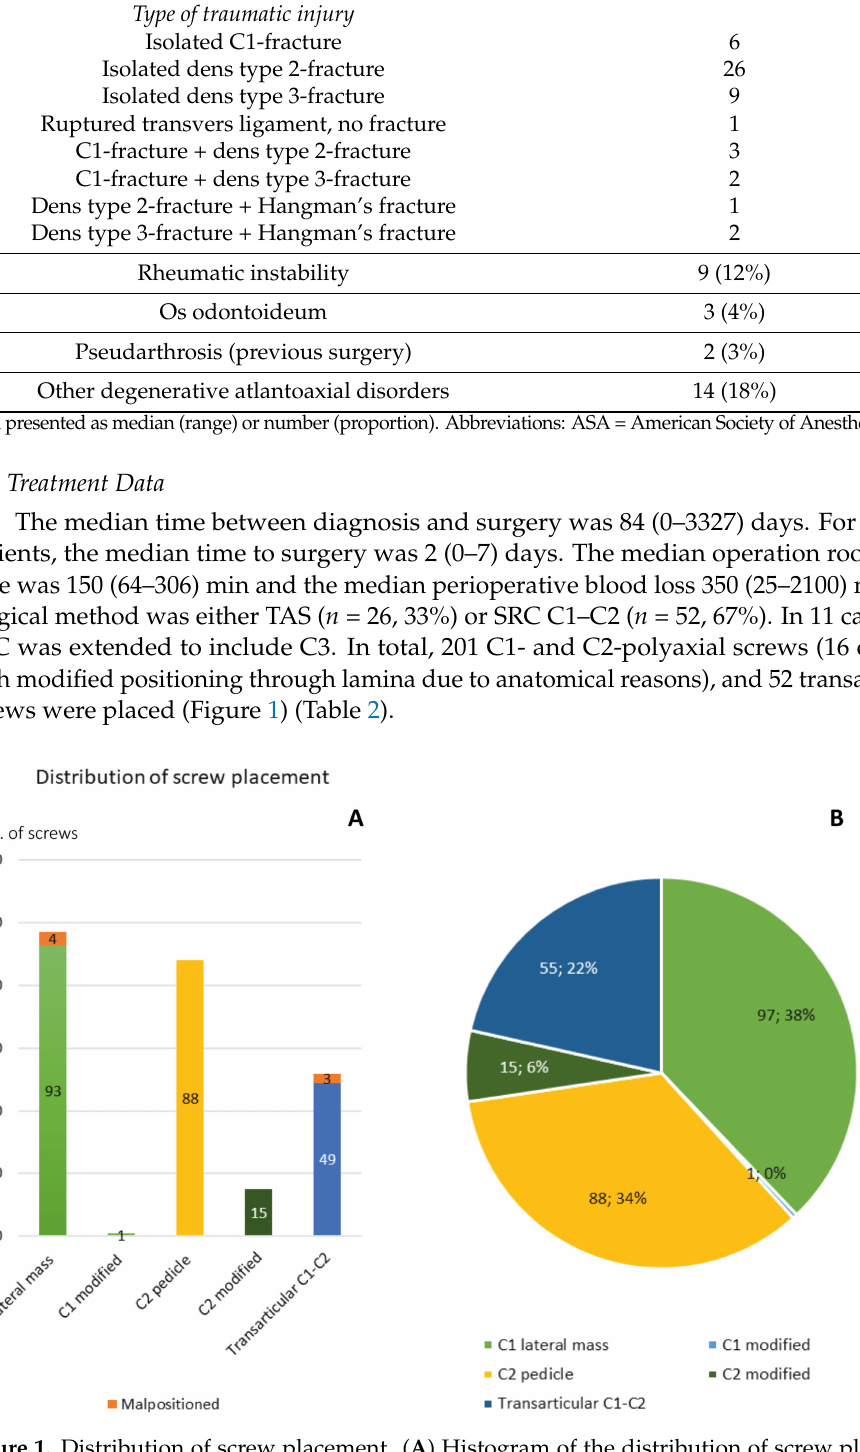
Figure 1. Distribution of screw placement. ( A ) Histogram of the distribution of screw placement types along with the number of malpositioned screws. ( B ) Relative distribution of screw placement types in absolute and numbers and